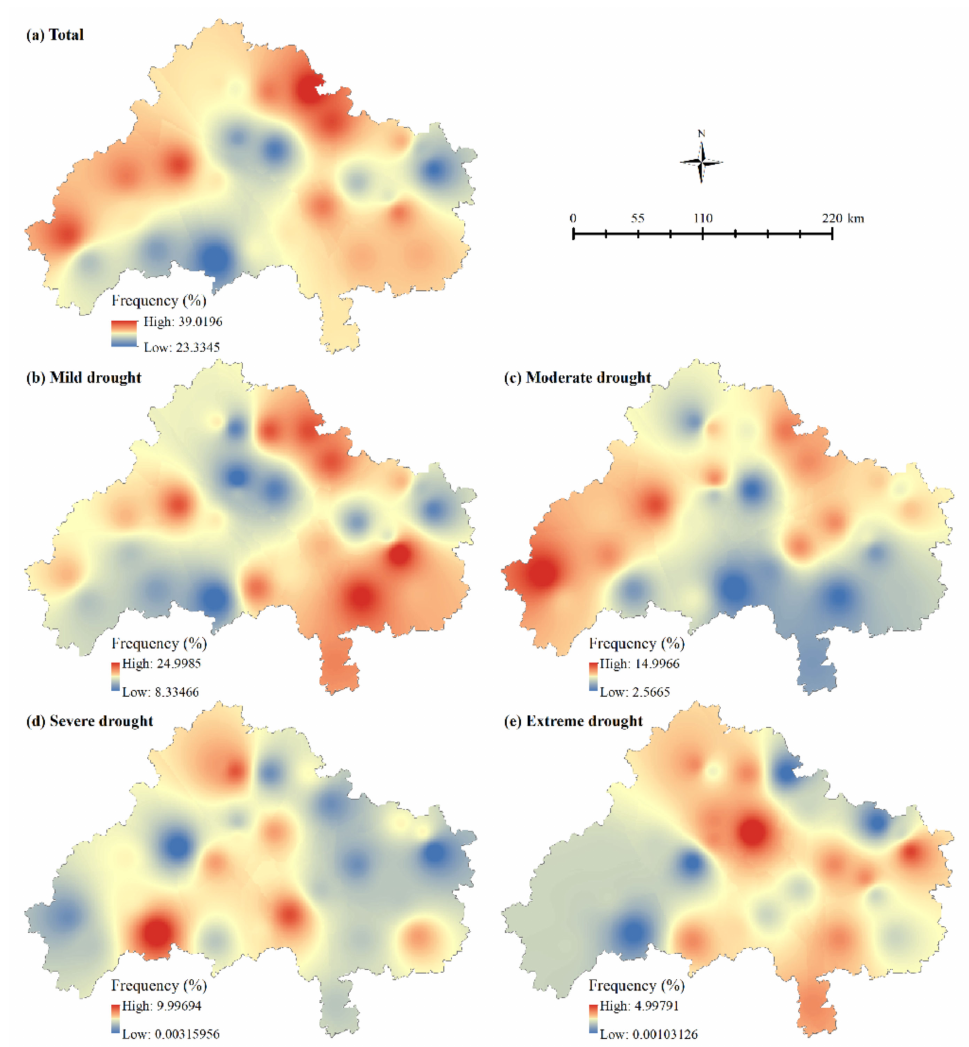
Figure 9. Spatial patterns of drought frequency at the annual scale in HSDC. ( a ) Frequency of all drought categories; ( b ) frequency of mild drought; ( c ) frequency of moderate drought; ( d ) frequency of severe drought; and ( e ) frequency of extreme